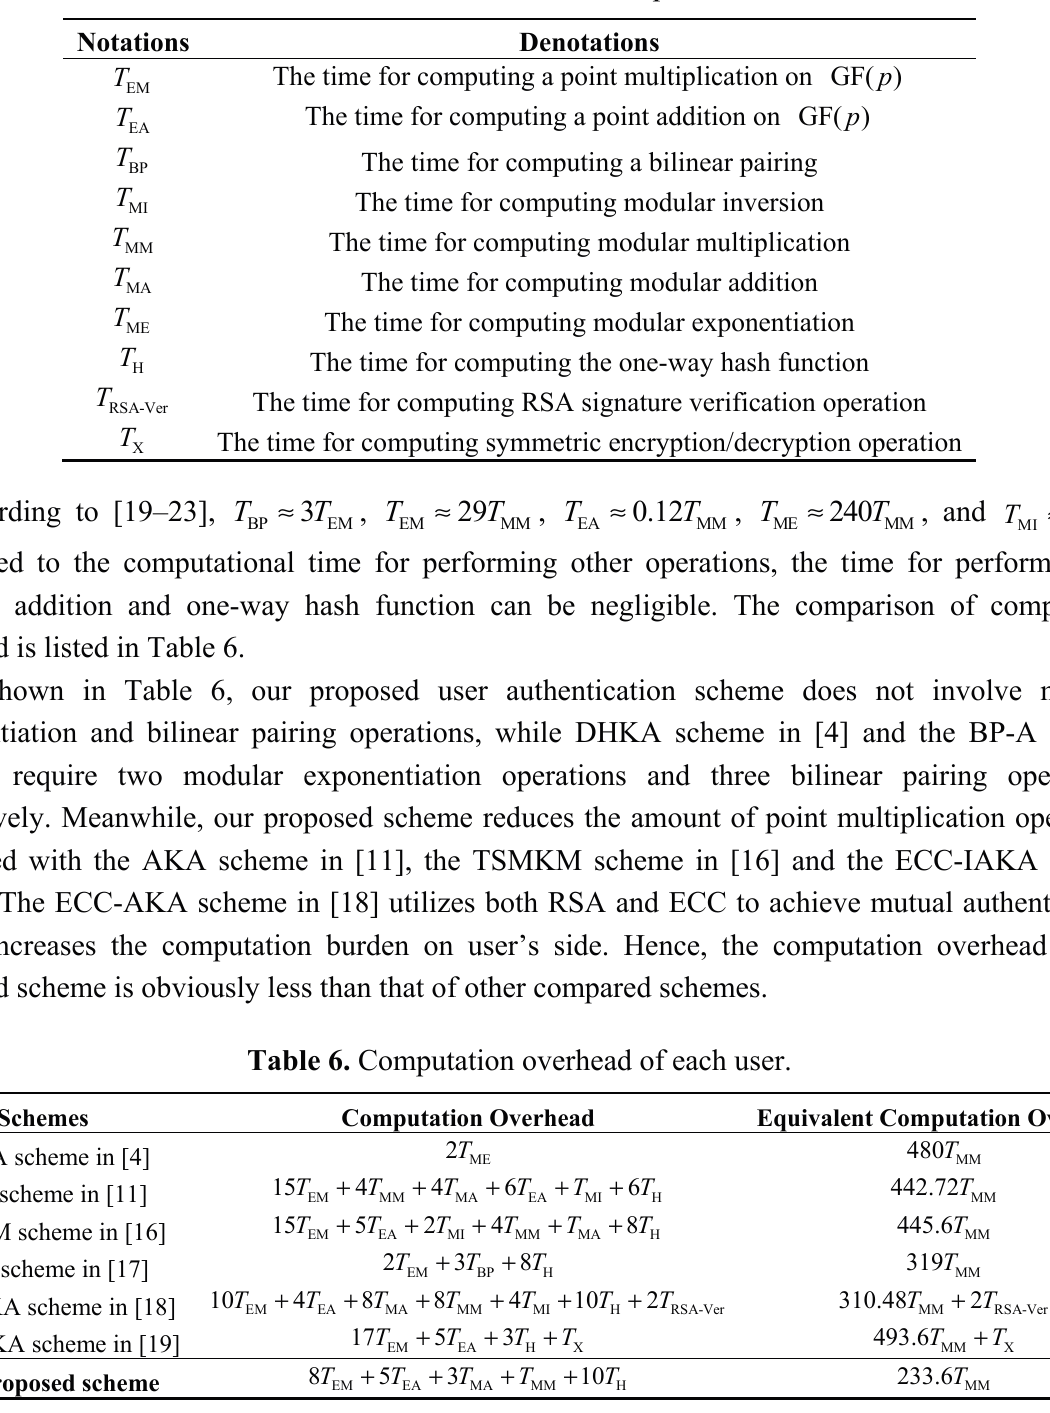
Table 5. Definition of various operations.